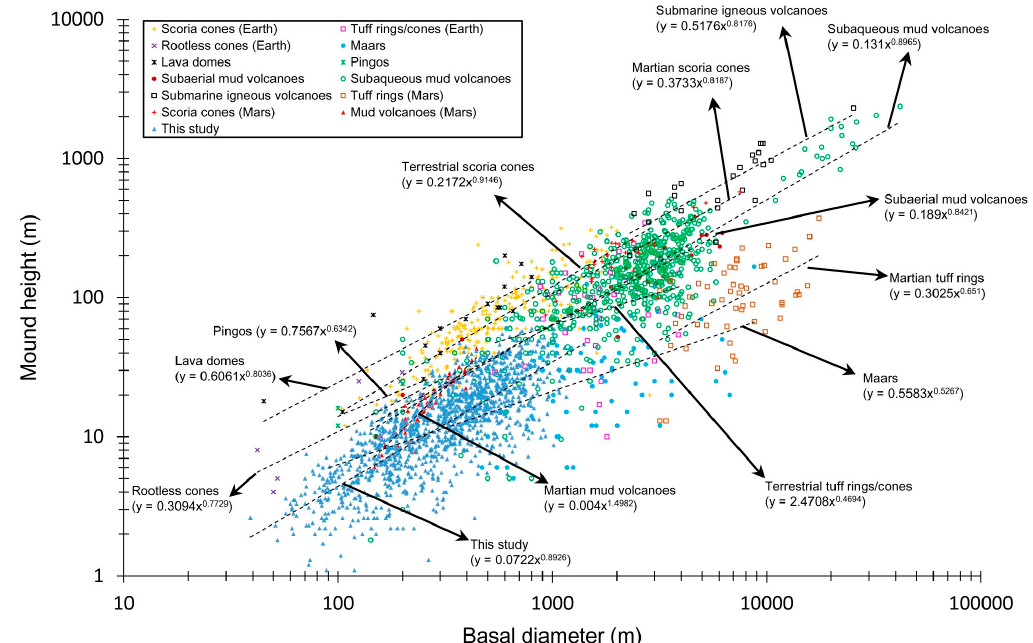
Figure 4. Log-log plot showing the measured maximum height ( H ) versus basal diameter ( W ) for 1297 pitted mounds in southern Acidalia Planitia (see also Table S1) and analogous features on Earth and Mars [22,76]. The dashed lines represent the best-fit power regression. Table 4. A summary of morphometric parameters of the mounds shown in Figure 4.